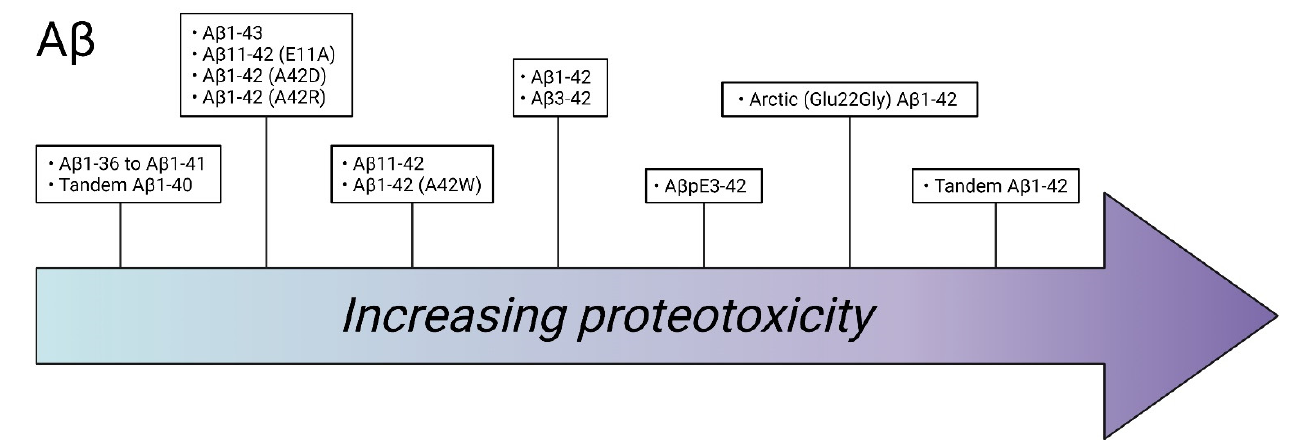
Figure 2. Estimated proteotoxicity for amyloid- β (A β ) variants examined in Drosophila . Variants with a similar degree of toxicity are grouped together. The figure was generated using BioRender.